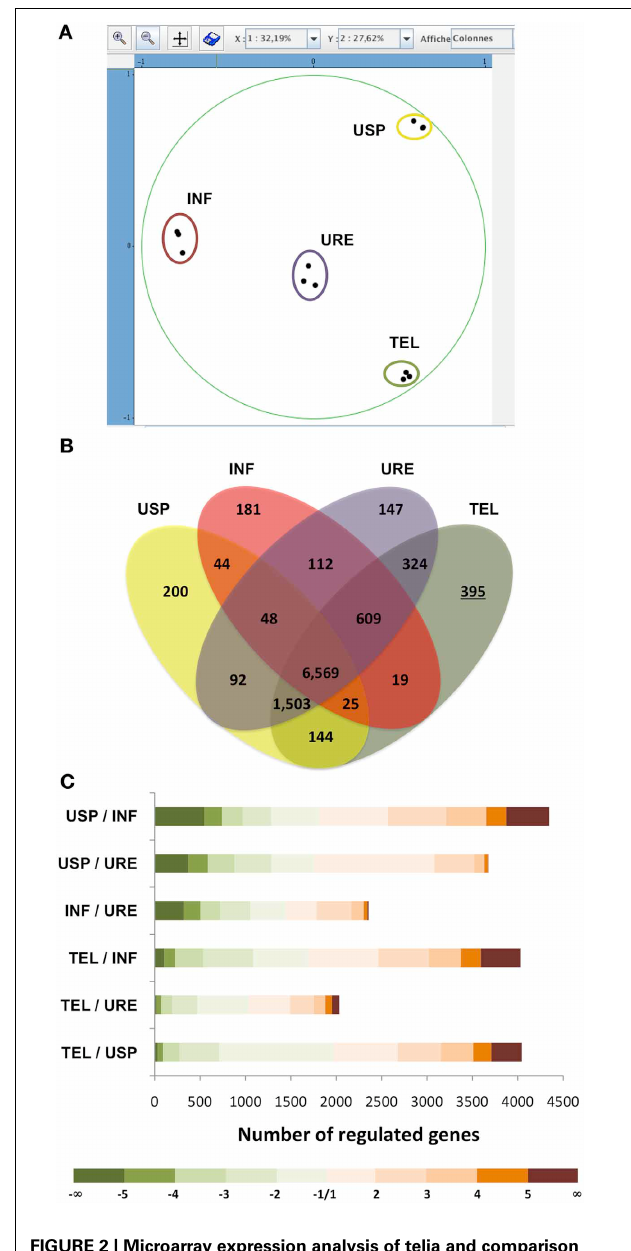
FIGURE 2 | Microarray expression analysis of telia and comparison with expression data of other fungal developmental stages. (A) Principal component analysis (PCA) of M. larici-populina transcript levels measured in urediniospores (USP), during infection (INF), in uredinia (URE), and in telia (TEL) using custom oligoarrays (three biological replicates per stage were used for the PCA). Expression level of each gene assessed in a given biological situation and a given biological replicate was reported to the mean expression level calculated for the 12 hybridizations (six conditions × three replicates) and was log 10 -normalized before proceeding with PCA. The PCA plot places biological conditions along the two axes (X and Y) explaining 32.19 and 27.62% of the variance observed within samples. (B) Venn diagram showing the number of M. larici-populina genes expressed in each condition. The underlined number corresponds to the number of genes specifically expressed in telia. (C) Number of genes significantly regulated between the analyzed fungal developmental stages [log 2 Fold-Change (FC) > 1, p < 0 . 05]. Color coding corresponds to log 2